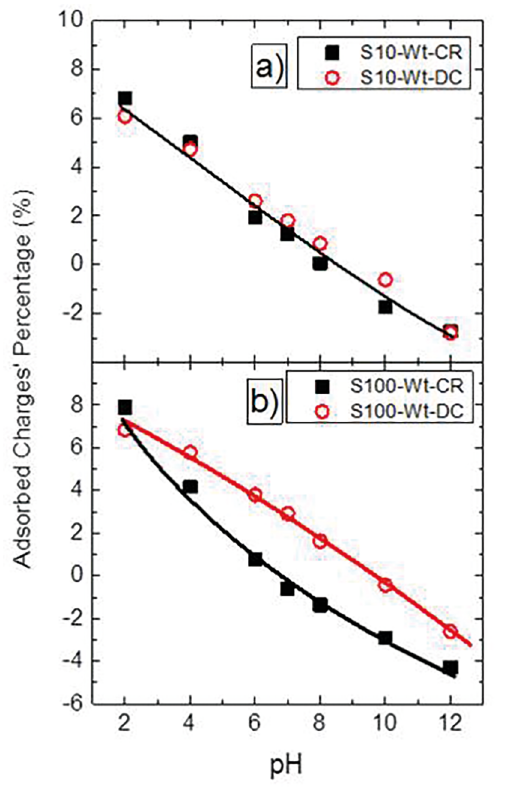
Figure 9. Percentage charge’s variation for samples cleaned in water: a) Crescent and Decrescent pH sequence for Sample S10; b) Crescent and Decrescent pH sequence for Sample S100. The lines shown in the figure are just eye guides. They do not represent any kind of mathematical instrument or